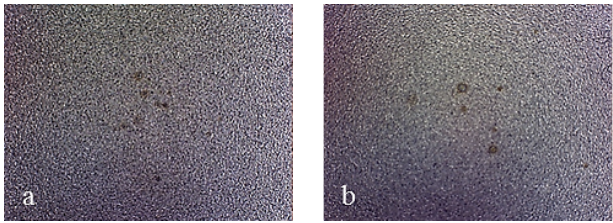
Figure 13. Working area after polarization on X37CrMoV5-1 steel, electro-eroded finish. ( a ) Multilayer 4; ( b ) Multilayer 8.